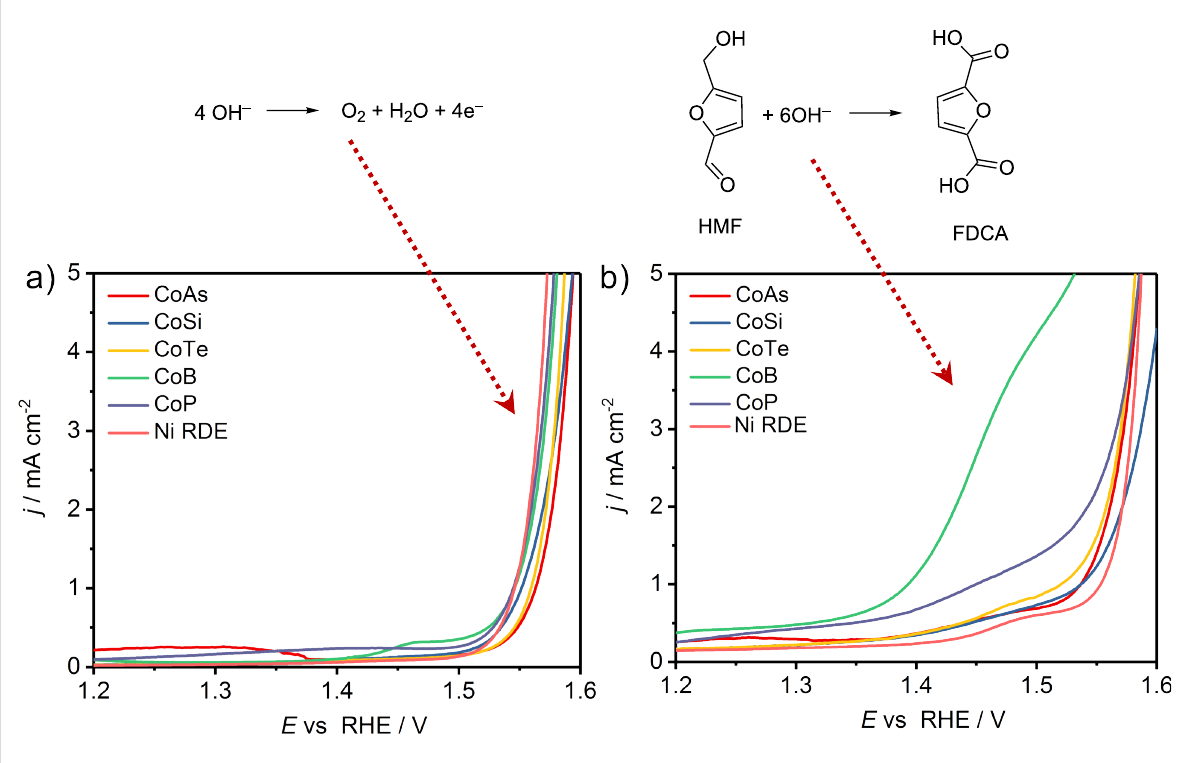
Figure 2: Linear sweep voltammograms of CoP, CoB, CoTe, Co 2 Si, CoAs modified and blank Ni RDEs for the OER (a) and the HMF oxidation (10 mM HMF) (b) (1600 rpm, 1 M KOH, 2 mV s − 1